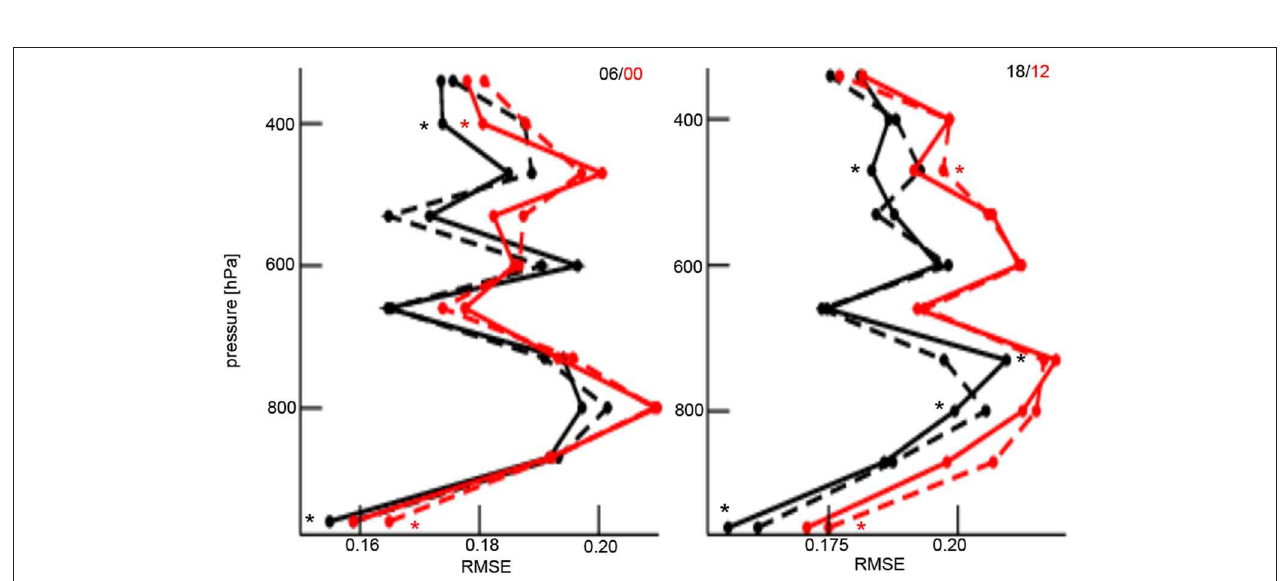
FIGURE 14 | Forecast root-mean square error of radiosonde relative humidity for different initial times and correspondingly different lead times in the winter period 2016. Black and red lines denote lead time 6 and 12 h, respectively; dashed lines and solid lines represent NO-SEVIRI and SEVIRI-NEW experiment, respectively. The results represent average results over the region and the full time period. All forecast statistics consider the same observations. The star denotes statistically significant differences between experiments.